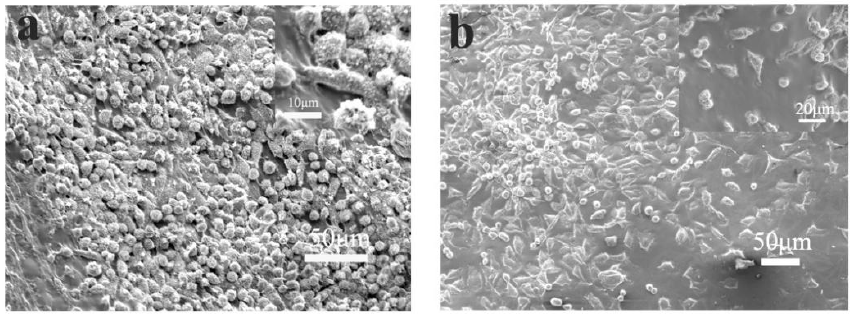
Figure 7. SEM image of L929 cells on day 7 of ( a ) PLA fibers; ( b ) PLA/PVA/SA fibers.